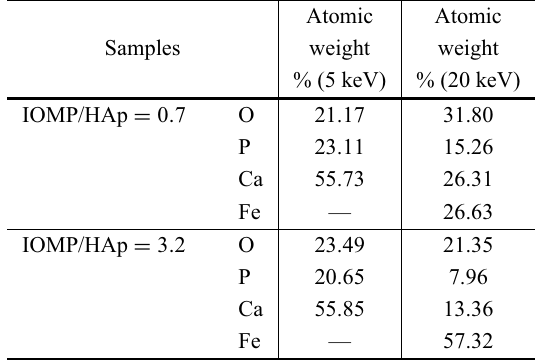
EDX analyses of hydroxyapatite-coated iron oxide magnetic particles display the comparative variation of elemental composition of the interior (with 20 keV) and the surface (with 5 keV).